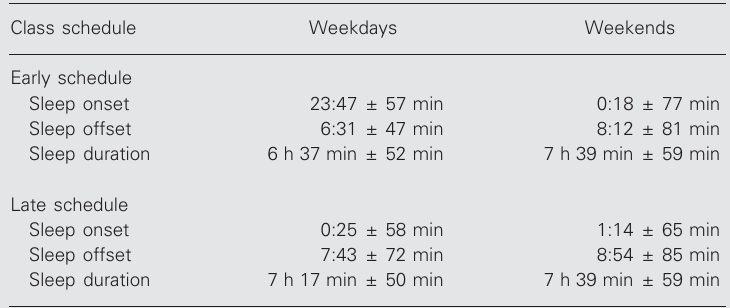
Table 1. Sleep variables on weekdays and weekends during the early and late class